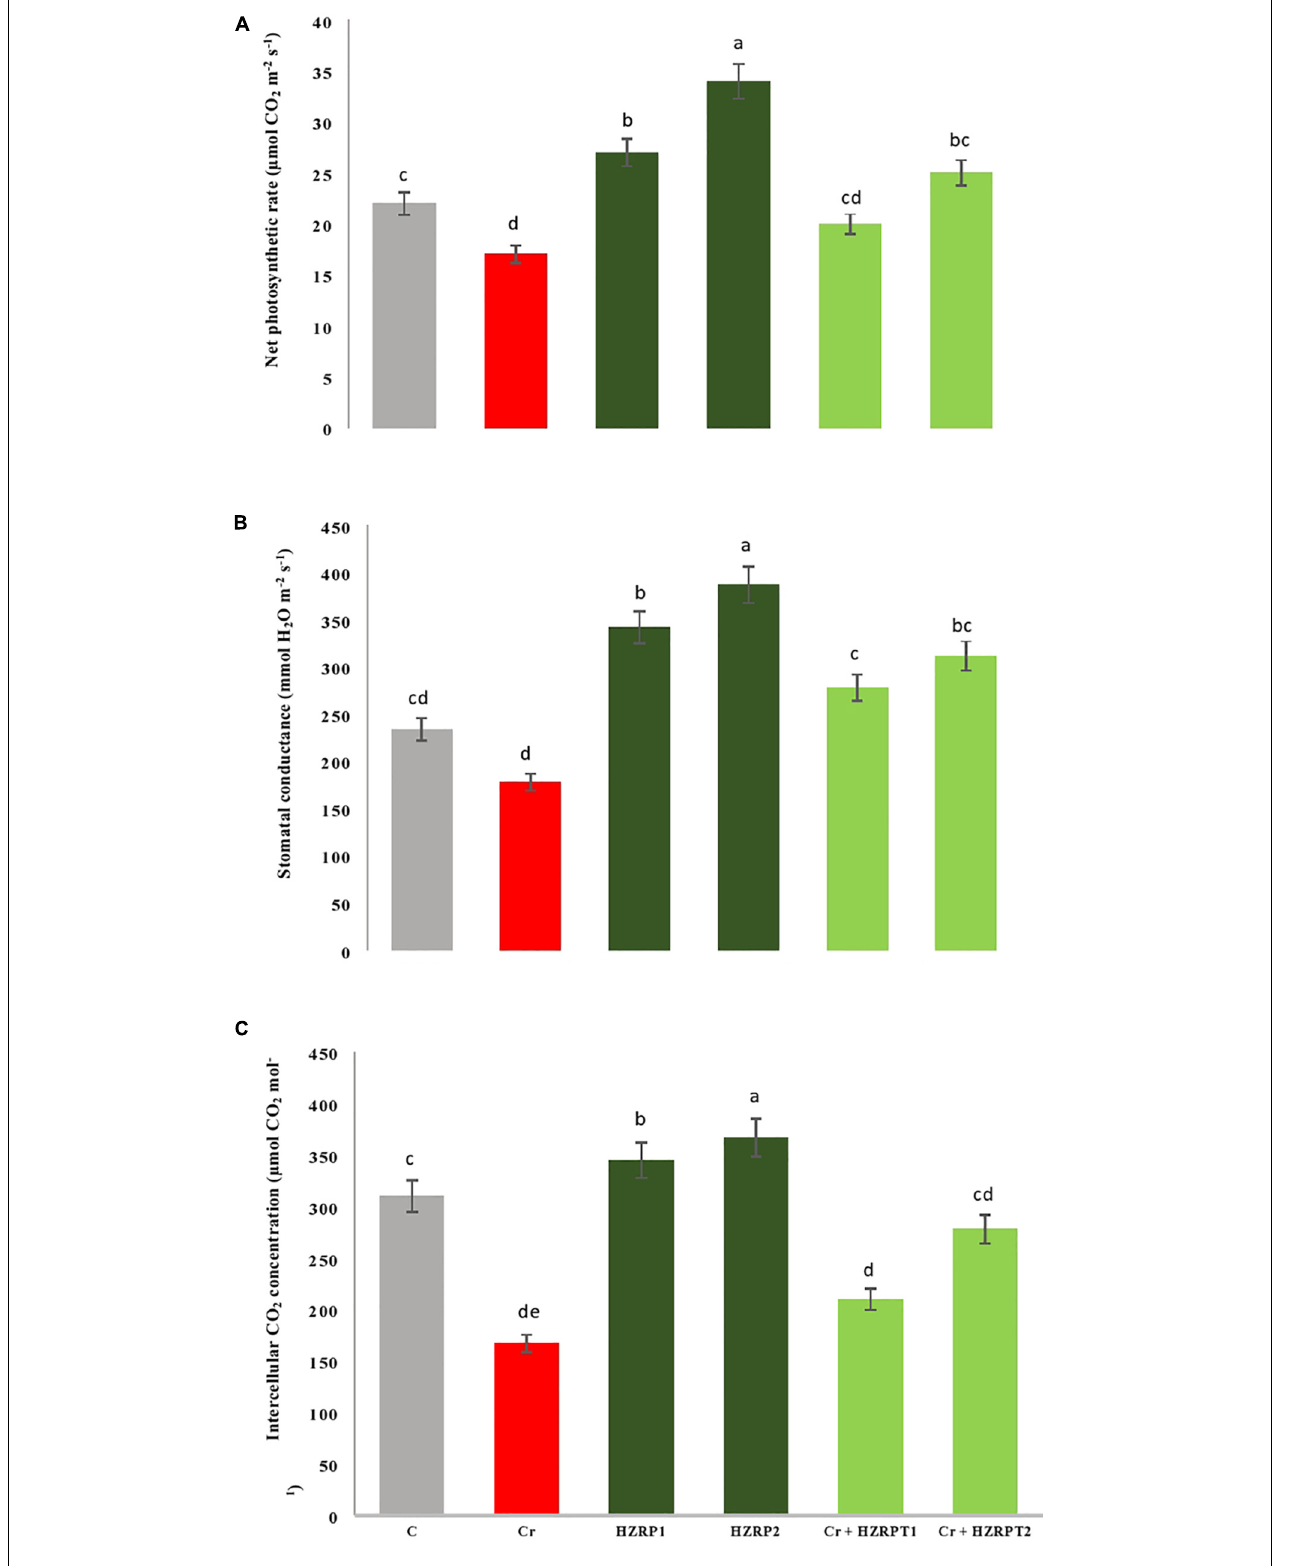
FIGURE 1 | Effect of harzianopyridone on net photosynthetic rate (A) , stomatal conductance (B) and intercellular CO 2 concentration (C) in V. radiata seedlings grown in Cr toxificated soil. Different letters indicate significant difference among the treatments ( p < 0.05). Cr, 50 mg kg − 1 , HZRP1, 1 p.p.m; HZRP2, 2 p.p.m.